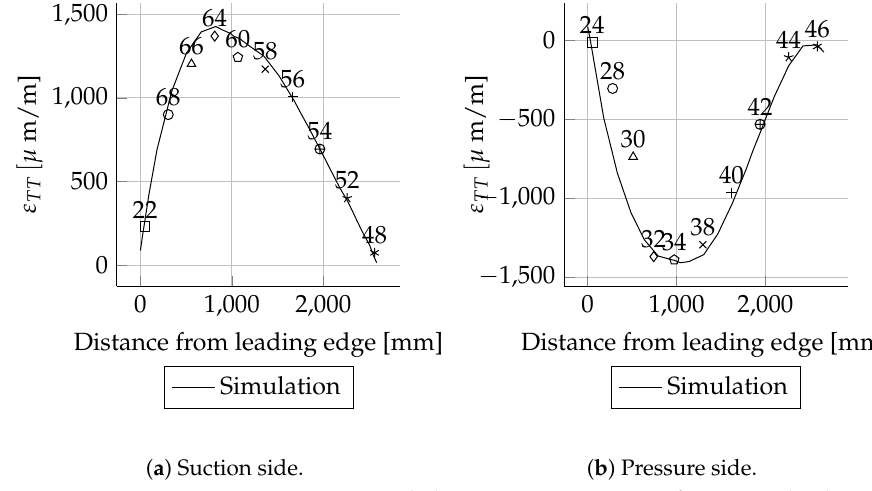
Figure A44. Strain comparison ε LL at radial position R = 5000 mm for Mymin load